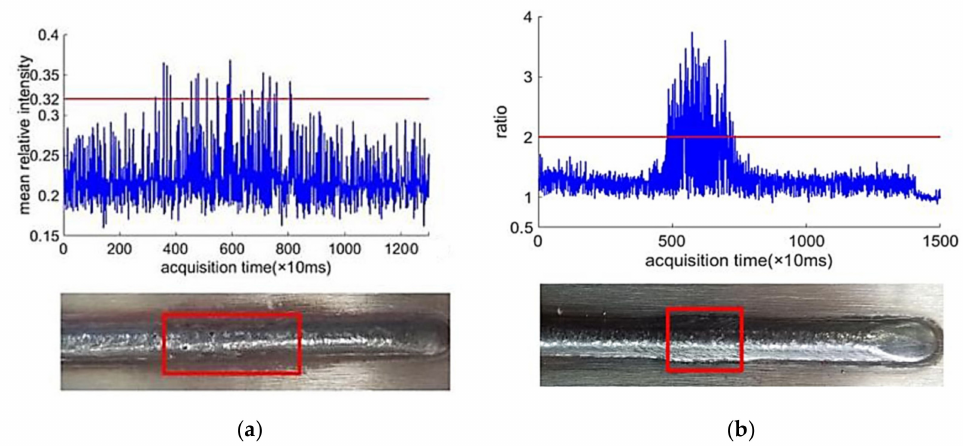
Figure 31. Spectral data of defects in weld: ( a ) base metal with or without rust; ( b ) base metal with or without oil stain. Reprinted with permission from Ref. [74]. Copyright 2019